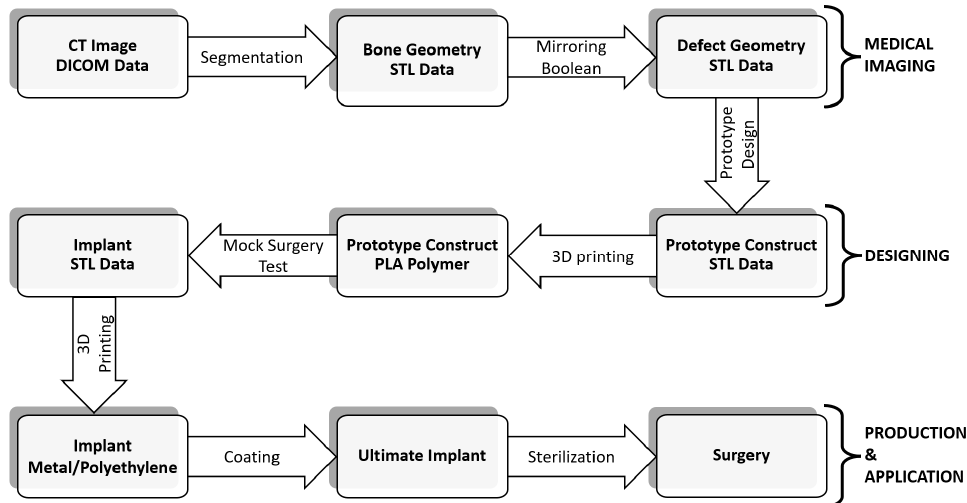
Figure 1. Workflow for medical imaging, designing, prototyping, production and surgical application of personalized 3D printed implants.